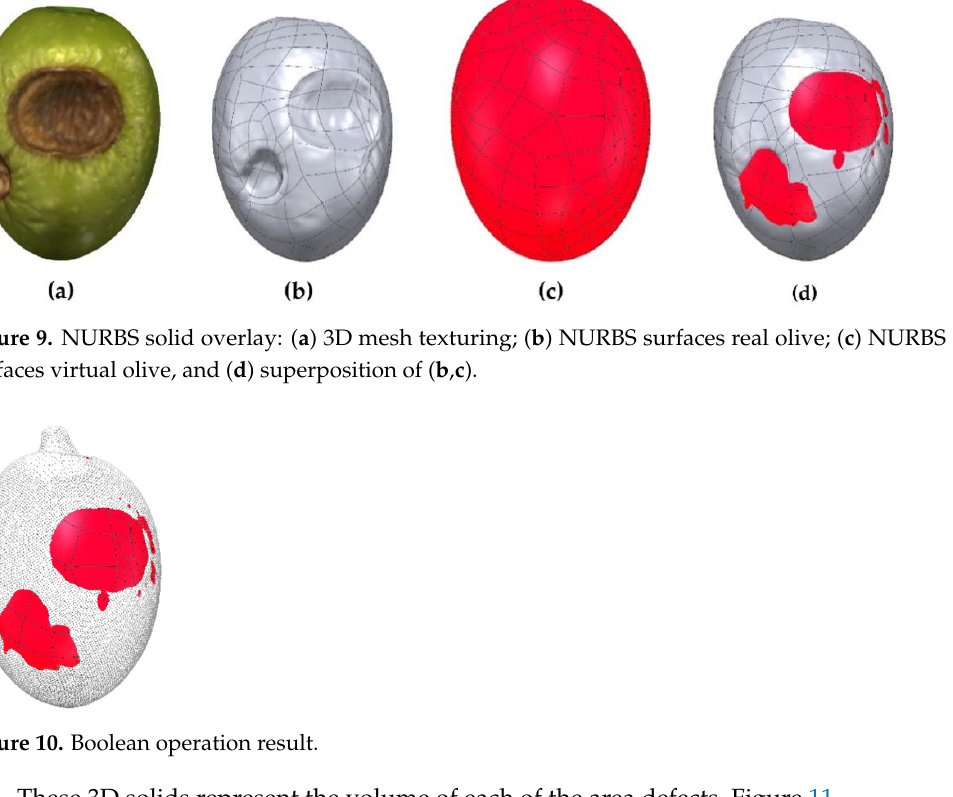
Figure 10. Boolean operation result.